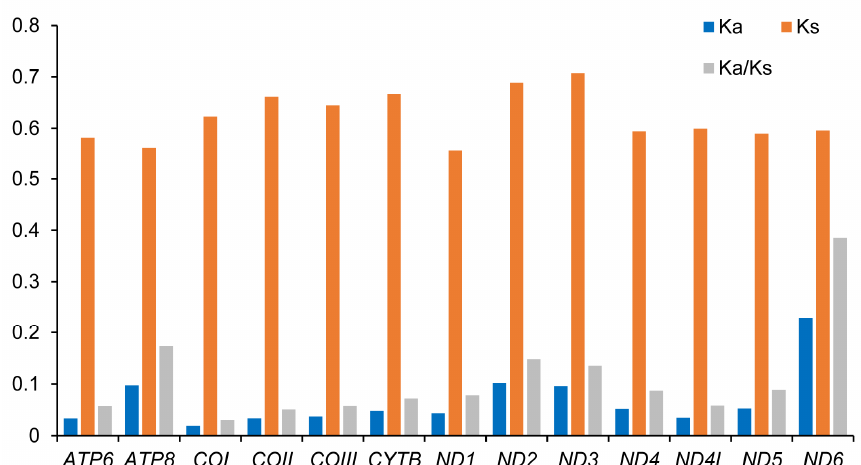
Figure 3. Evolutionary rates of taeniopterygid mitogenomes. The non-synonymous substitutions rate (Ka), the synonymous substitutions rate (Ks), and the ratio of the rate of non-synonymous substitutions to the rate of synonymous substitutions (Ka/Ks) for each PCG.